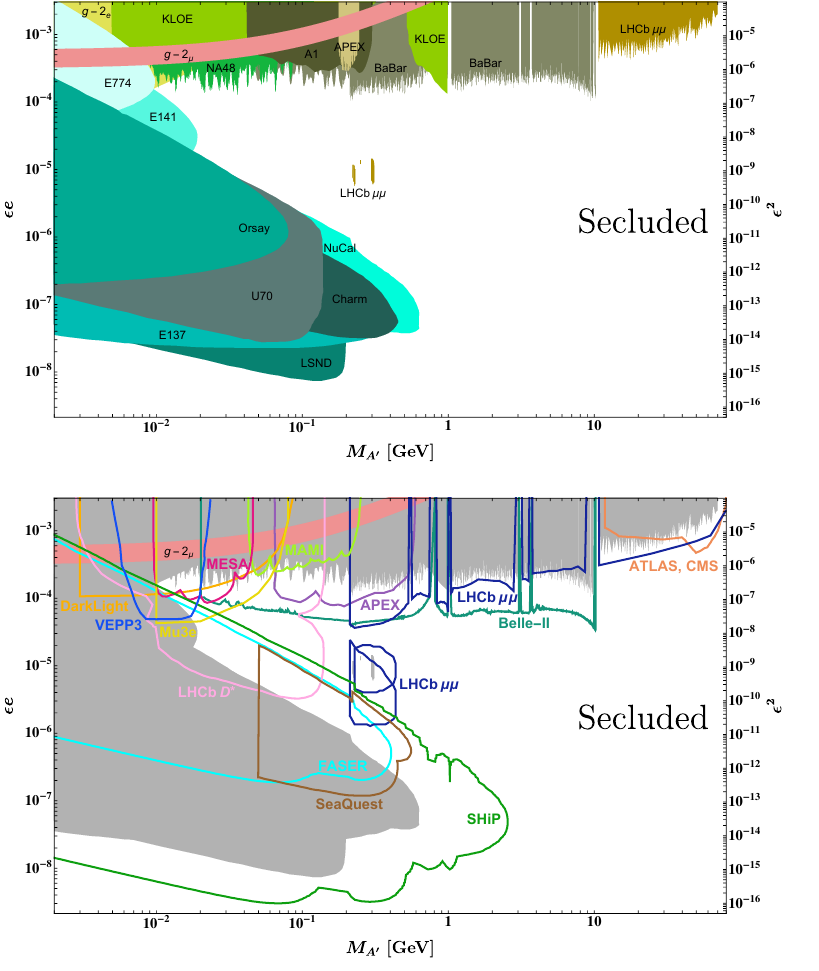
Figure 12 . Constraints from current (upper panel) and future (lower panel) experiments on a se- cluded U(1) X gauge boson with kinetic mixing parameter (cid:15) . Additional constraints from supernova cooling are not shown (see section